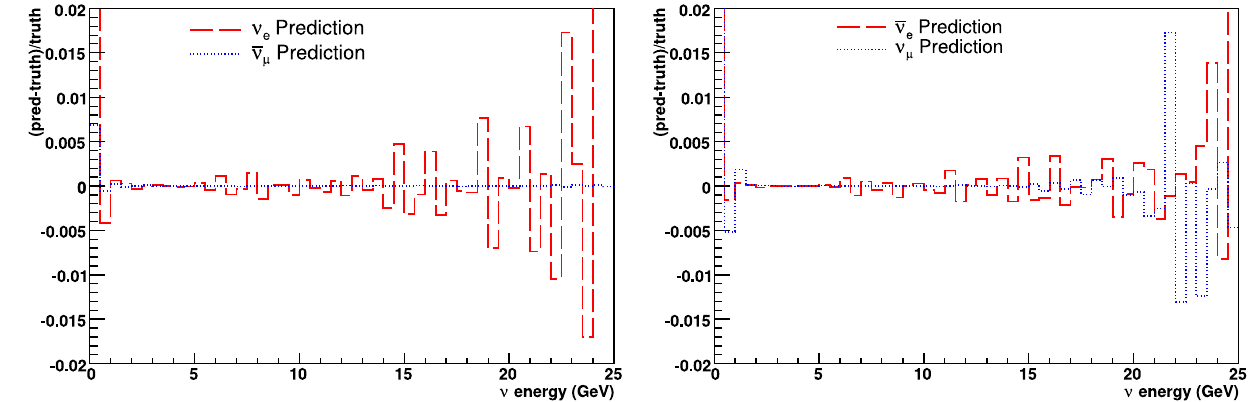
FIG. 19. Comparison of predicted to true flux through the ND for stored (cid:3) þ (left) and stored (cid:3) (cid:1)